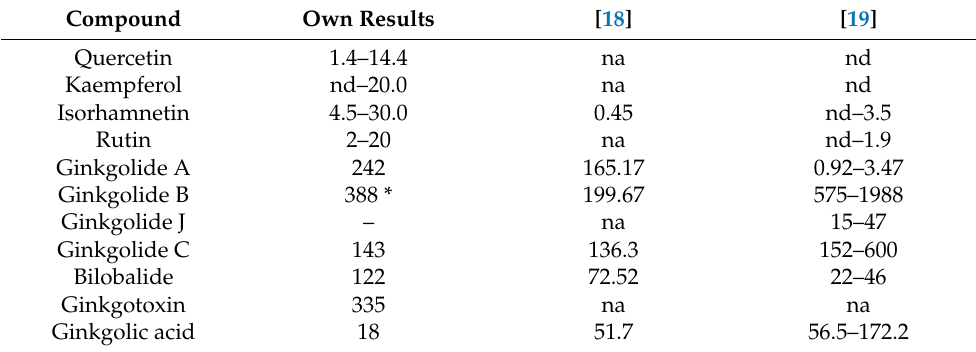
Table 4. Amounts of bioactive compounds in Ginkgo biloba seed extracts. The results are presented in µ g/g of dry